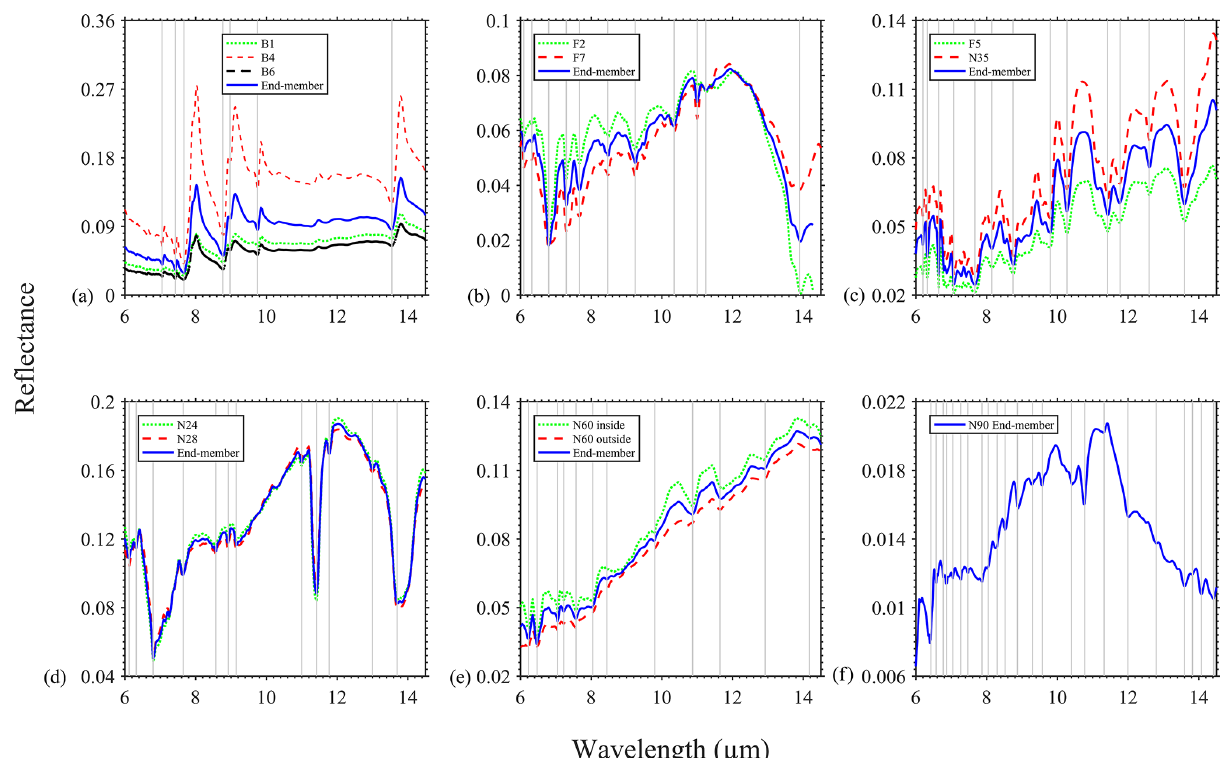
Figure 9. Spectral reflectance of other anthropogenic materials: (a) green plastic bottle pieces and transparent strip, (b) mesh and fishing net, (c) black construction materials, (d) gunny-sack-like patch, (e) polyurethane foam piece, and (f) nautical cargo strap in Fig. 1 gathered along the shorelines of Punta Mallil-Cuem, Detif and Punta Apabón on the Chiloé Archipelago, Chile. An end-member spectrum is proposed with diagnostic absorption features highlighted by the vertical